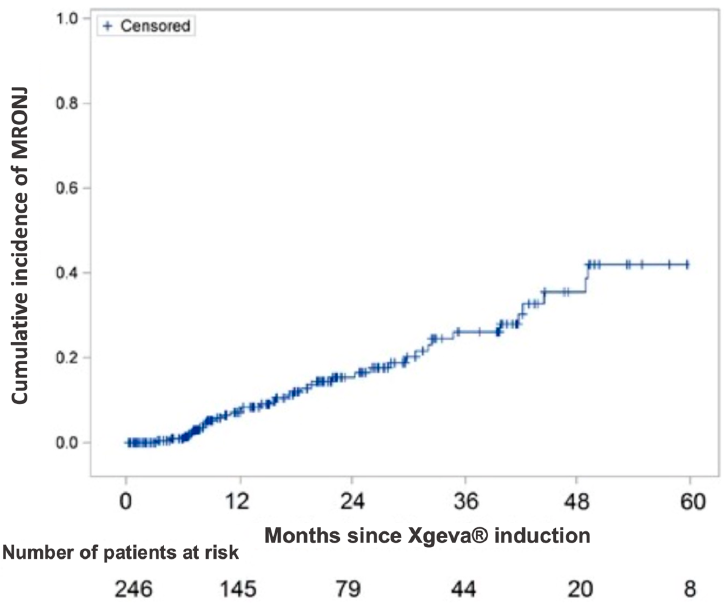
Figure 1. Incidence of MRONJ according to Kaplan–Meier estimator (N = 246).